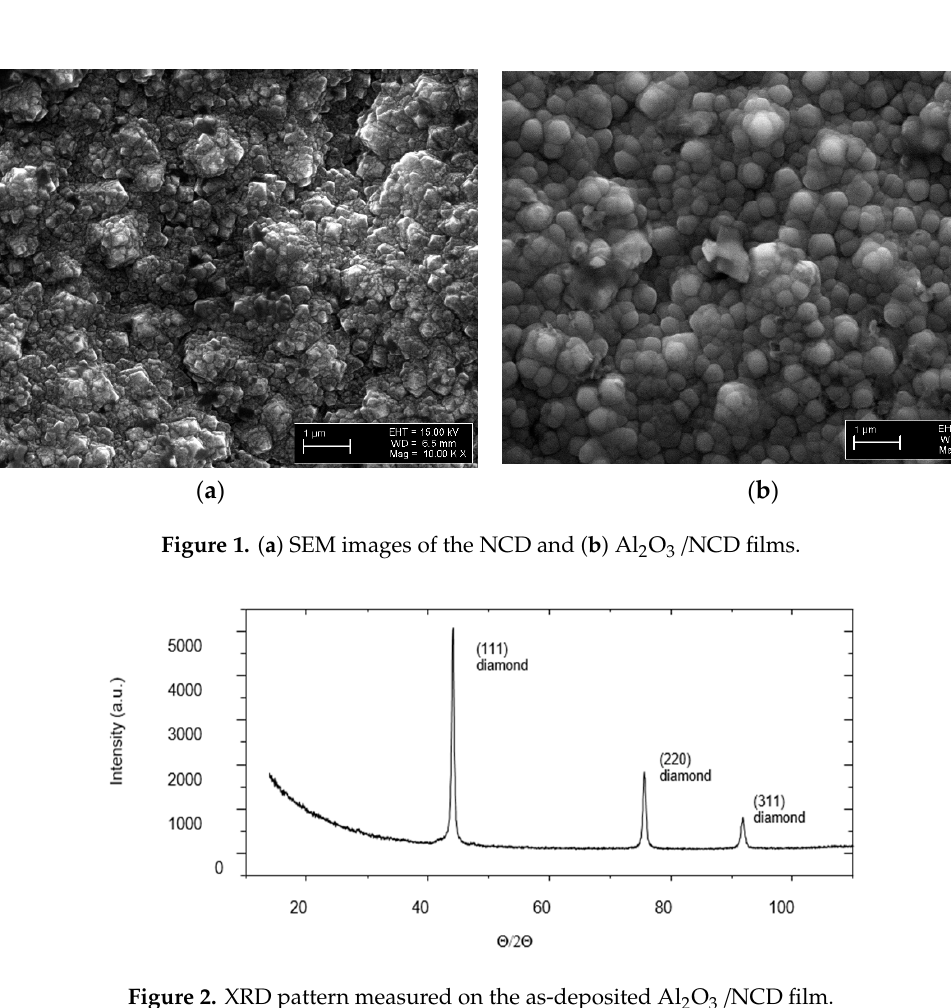
Figure 2. XRD pattern measured on the as-deposited Al 2 O 3 /NCD film.